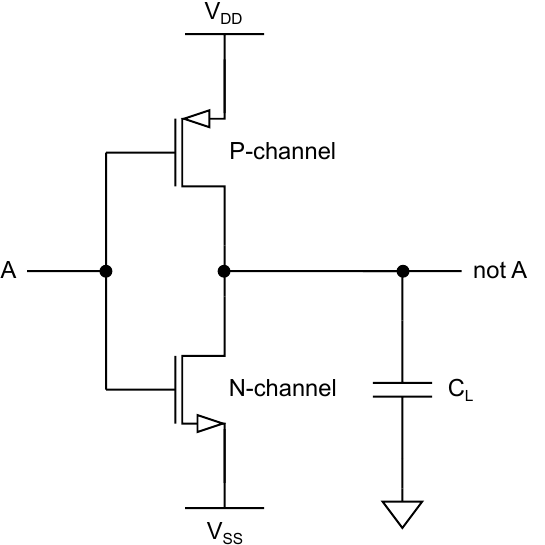
Figure 1. A CMOS inverter model.